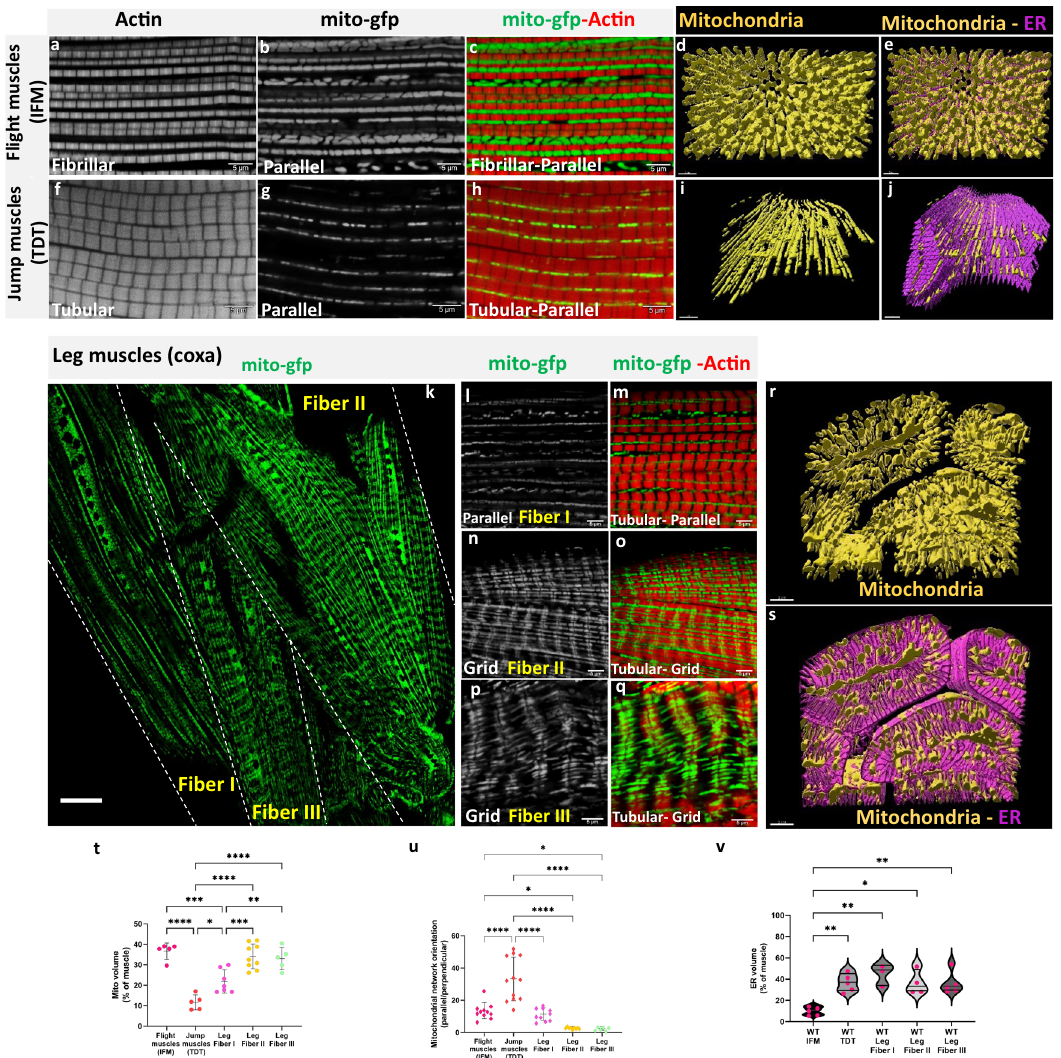
Fig. 1 | Mitochondrial network organization in adult Drosophila muscles. a , b , c Fibrillar fl ight muscles (IFMs) stained for F - actin and mitochondria expressing mito-gfp driven by DMef2-Gal4 showing parallel aligned mitochondria that are large, tube-like, and packed between myo fi brils (Scale Bars: 5 μ m). d , e Representative 3Drendering of electron microscopicimagesof mitochondrial arrangement (yellow) and ER (magenta) in fl ight muscles. f , g , h Tubular jump muscles show mitochondria that are thin and elongated arranged in parallel mitochondrial networks (Scale Bars: 5 μ m). i , j Representative 3D rendering of mitochondrial networks (yellow) and ER (magenta) in jump muscles. k In walking (leg) muscles, DMef2-Gal4 driven mito-gfp shows both parallel and grid-like mito- chondrial networks (marked with dashed line, scale bar: 20 μ m). l , m Tubular leg muscle Fiber I showing primarily parallel mitochondrial networks. n , o Tubularleg muscle Fiber II showing a grid-likemitochondrial network. p , q Tubular legmuscle Fiber III showing grid-like mitochondria. (Scale Bars: 5 μ m for all).